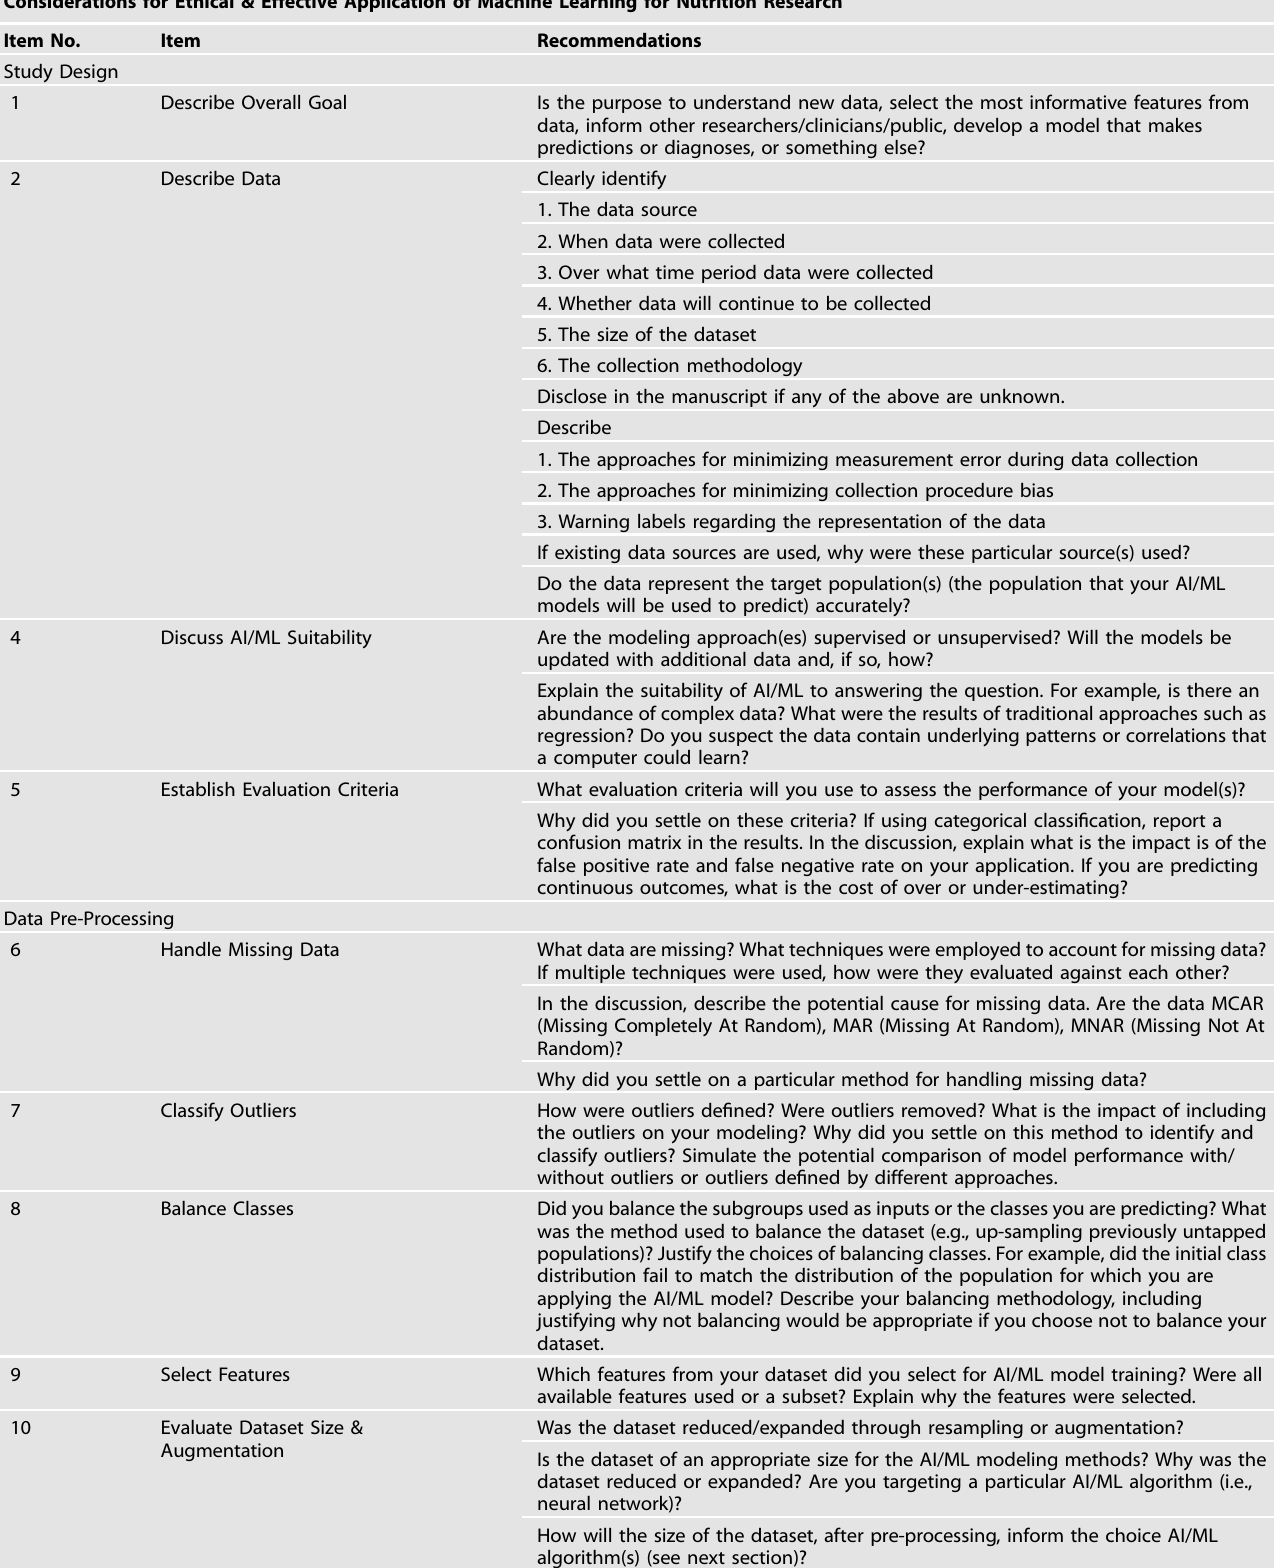
Table 2. Checklist for ethical and effective application of AI/ML modeling in nutrition research. Considerations for Ethical & Effective Application of Machine Learning for Nutrition Research Item